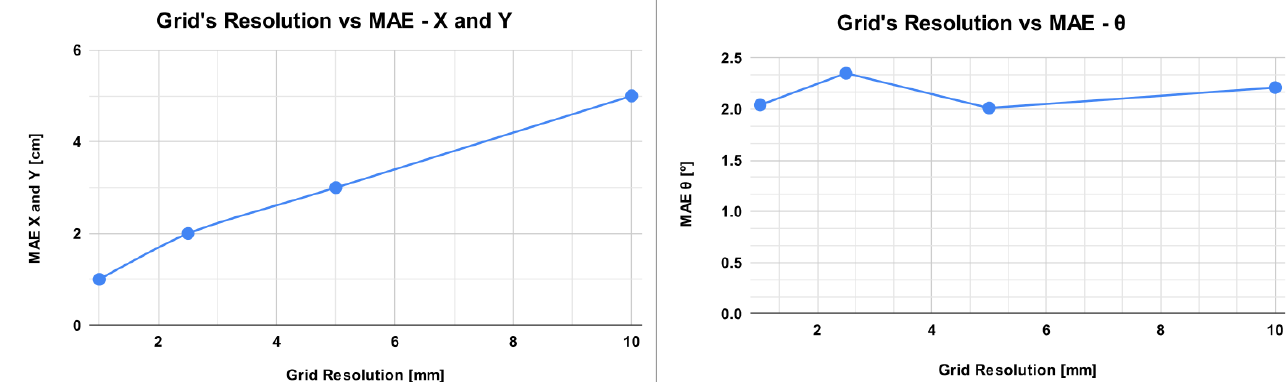
Figure 12. Comparison of the error obtained against the decrease in the grid’s resolution. The graph on the left displays the MAE for the x and y axes in centimeters (the same curve is for both values), while the image on the right displays the MAE for the θ in